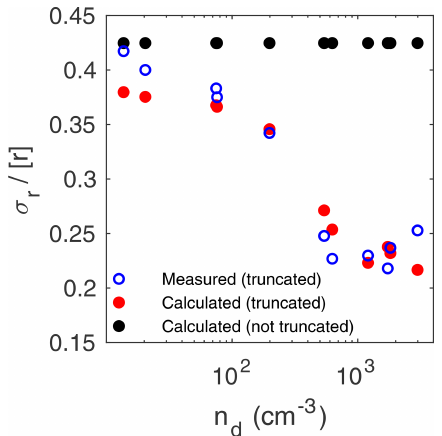
Figure 9. Relative dispersion of the radius versus droplet number concentration. The measured values of dispersion are from DSDs truncated at r = 2 . 5µm (blue circles) (Chandrakar et al., 2018b). The calculated values of dispersion used the average C implied by the three measured moments for each of the 11 DSDs. They were obtained by assuming either DSDs truncated at r = 2 . 5µm (red dots) or not truncated (black dots) and used Eqs. (46) and (28) or (47), respectively, with h =